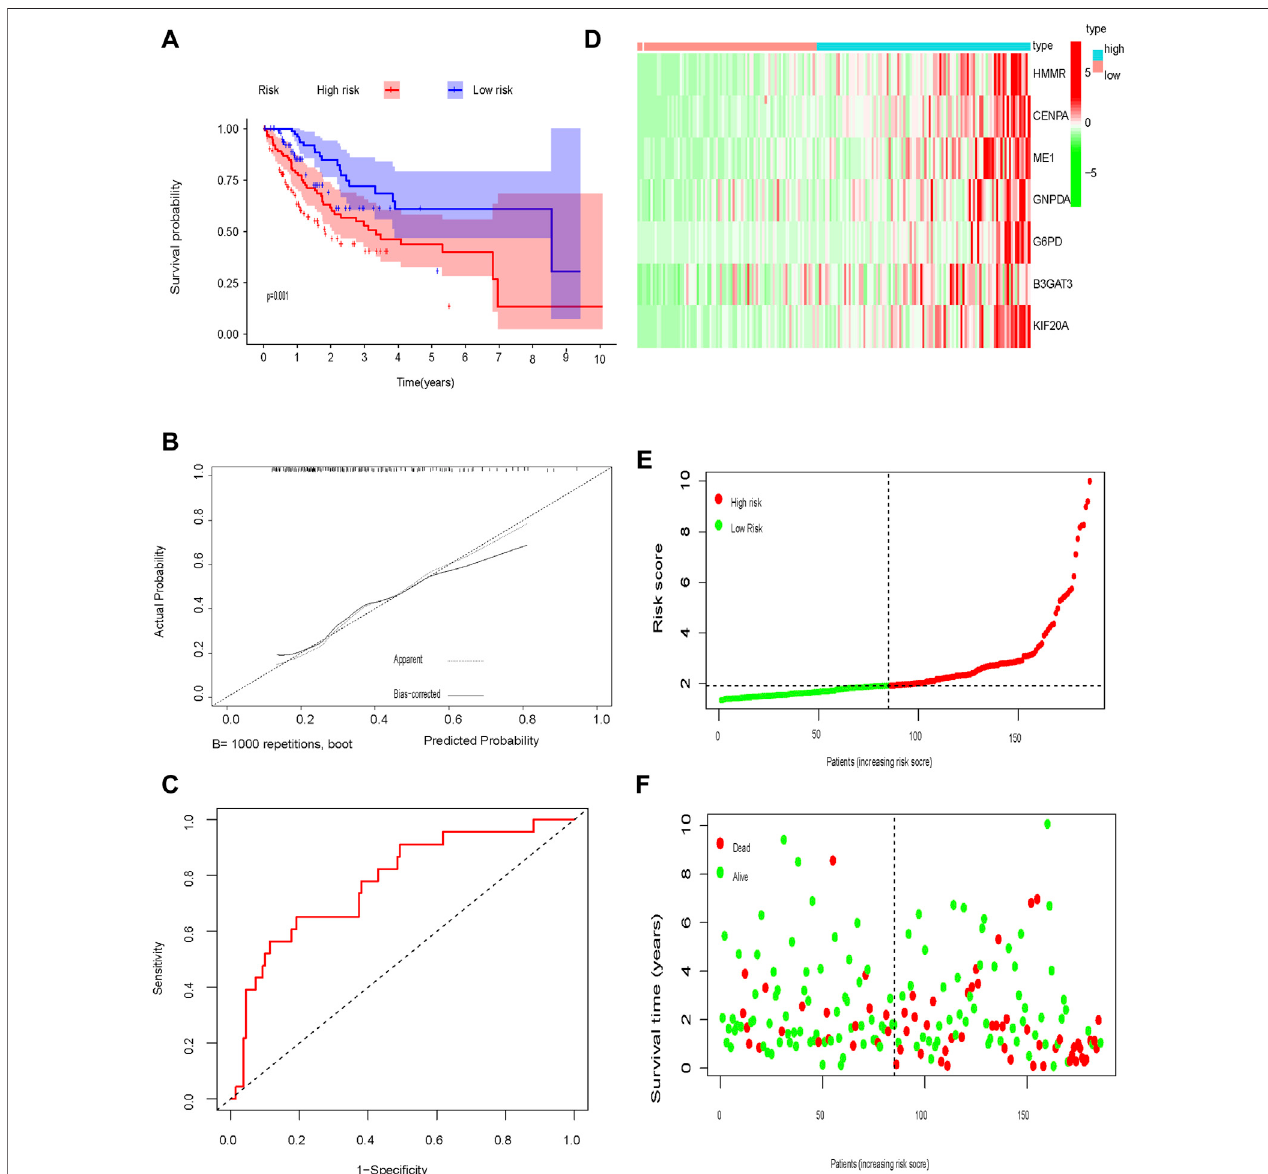
FIGURE 6 | Test set (A) Kaplan-Meier curve; (B) Calibration curve; (C) Time-dependent ROC curve analysis; (D) Heat map of glycolysis-related gene expression; (E) Distribution of risk scores; (F) Survival time.